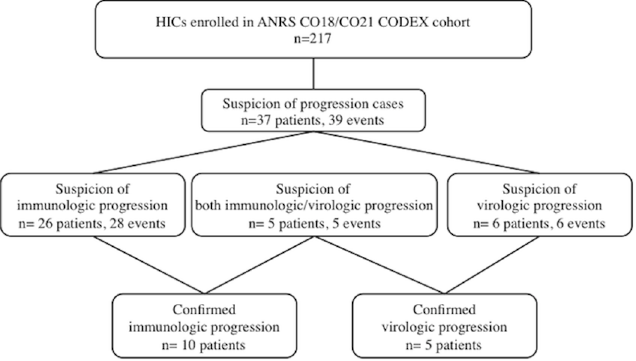
Fig 1. Study flow diagram. ANRS: Agence Nationale de Recherche sur le SIDA et les Hépatites Virales , cART: antiretroviral therapy, CODEX: Cohorte des Extr ê mes study, HICs: HIV controllers.